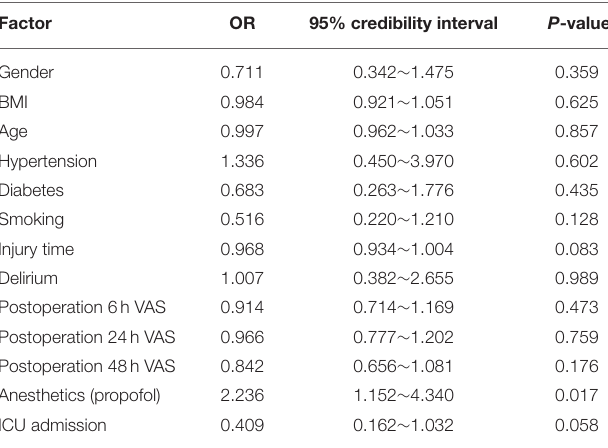
TABLE 4 | Logistic regression analysis for factors related to postoperative PTSD in patients with emergency